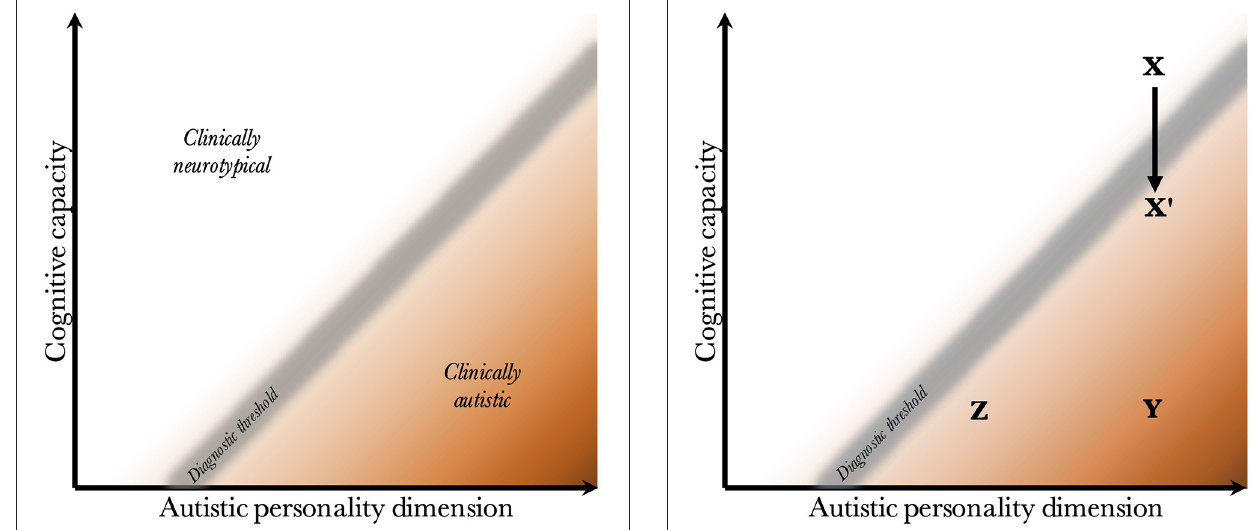
FIGURE 2 | Relationship between cognitive capacity and the autistic personality dimension. This figure illustrates why a higher cognitive capacity, and thus ability to compensate for various behavioral issues, decreases the probability that the intensity of the autistic personality is behaviorally maladaptive. The diagnostic threshold separates the clinical phenotypes into those that are clinically neurotypical and those that fulfill diagnostic criteria for autism. It is a fuzzy demarcation due to the difficulty in determining diagnostic status in borderline cases. The shading below the threshold corresponds to the severity of the clinical phenotype, the probability of having attracted clinical attention and received a diagnosis, and the stability of the diagnosis over time. The true diagnostic threshold is not necessarily straight, but is likely somewhat parabolic and slightly levels off with increasing cognitive capacity.